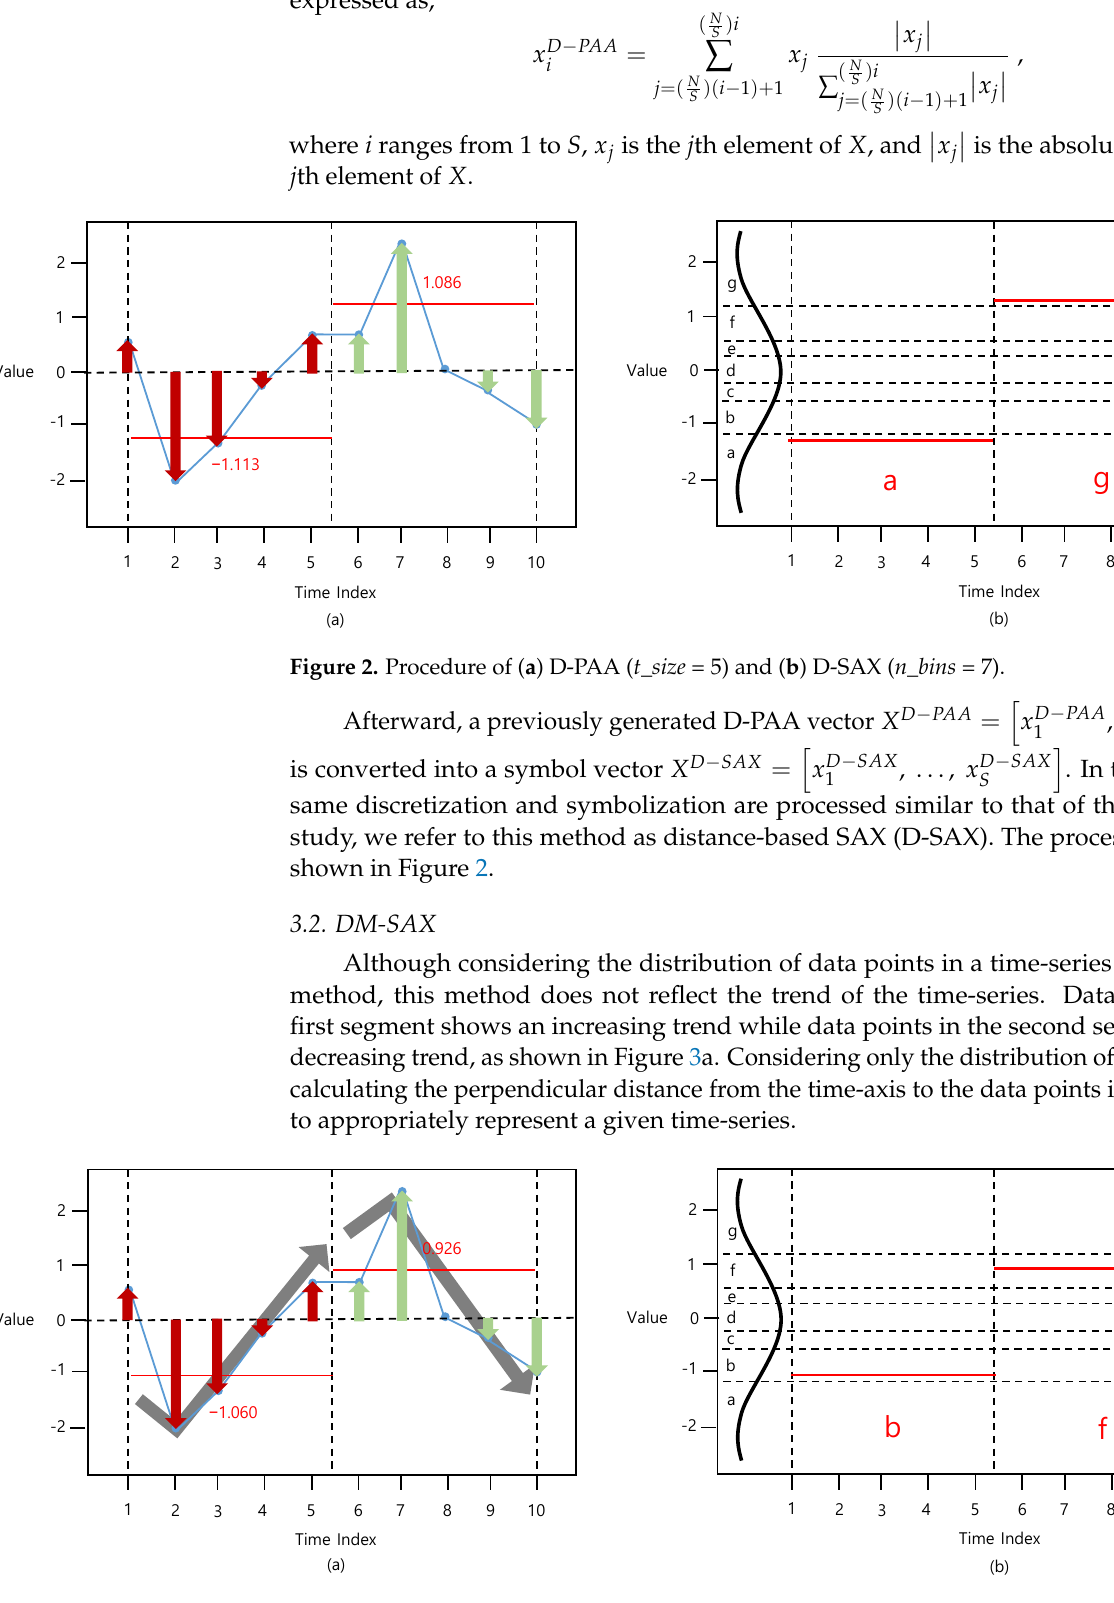
Figure 3. Procedure of ( a ) DM-PAA ( t_size = 5) and ( b ) DM-SAX ( n_bins =